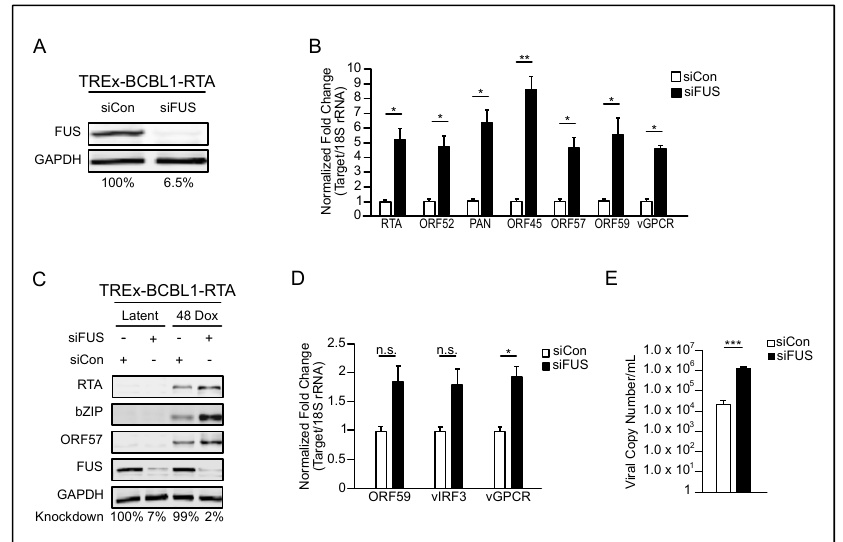
Figure 1. Fused-in-sarcoma (FUS) represses Kaposi’s sarcoma-associated herpesvirus (KSHV) reactivation in primary effusion lymphoma (PEL) cells. ( A ) Western blot analysis of FUS expression 48 h post reactivation in TREx-BCBL1-RTA cells treatmented with the indicated siRNAs. Knockdown efficiency is indicated beneath each lane. ( B ) RT-qPCR of viral transcripts from cells in ( A ). All samples were normalized to 18S and siCon levels set to 1. ( C ) Western blot of viral proteins from cells in ( A ). ( D ) TREx-BCBL1-RTA cells were transfected with the indicated siRNAs for 18 h prior to RNA isolation and RT-qPCR. All samples were normalized to 18S and siCon levels set to 1. ( E ) TREx-BCBL1-RTA cells were depleted of FUS for 18 h, followed by reactivation with doxycycline and sodium butyrate for 48 h. Virus and cells were centrifuged, viral genomes present were determined as described in the methods..